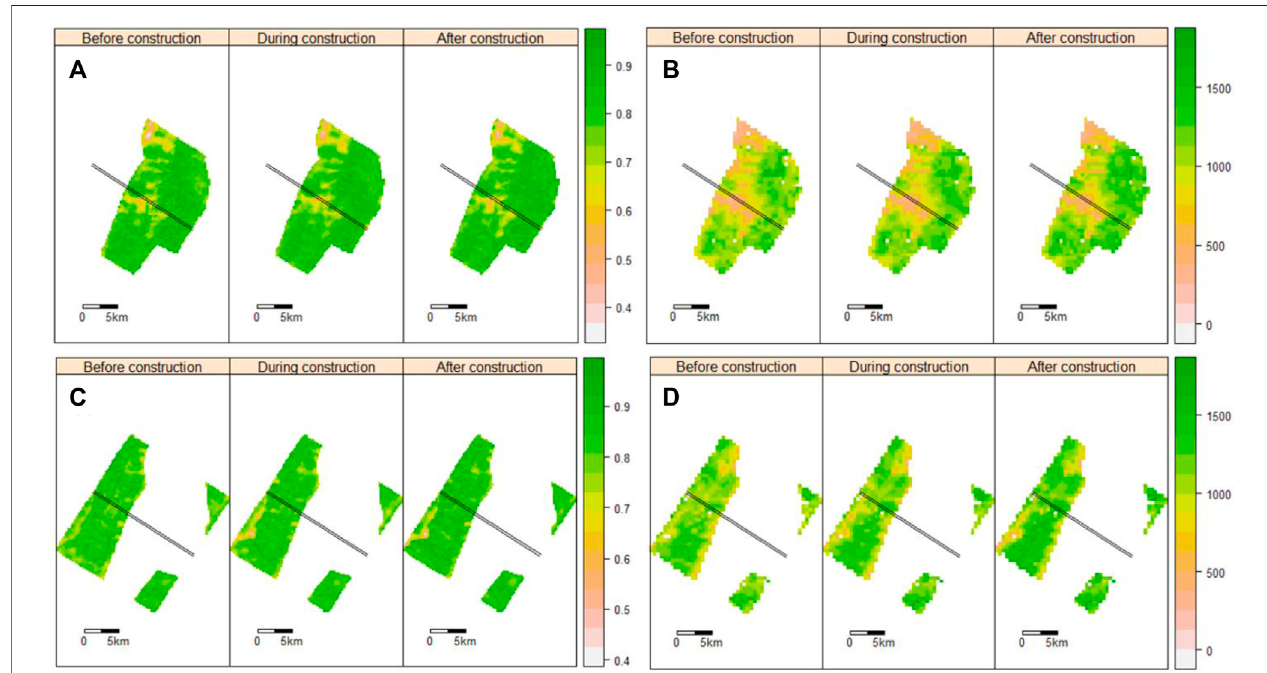
FIGURE 4 | Spatial distribution of mean NDVI (A,C) and GPP (B,D) before, during, and after constructions in the non-karst (A,B) and karst areas (C,D) .